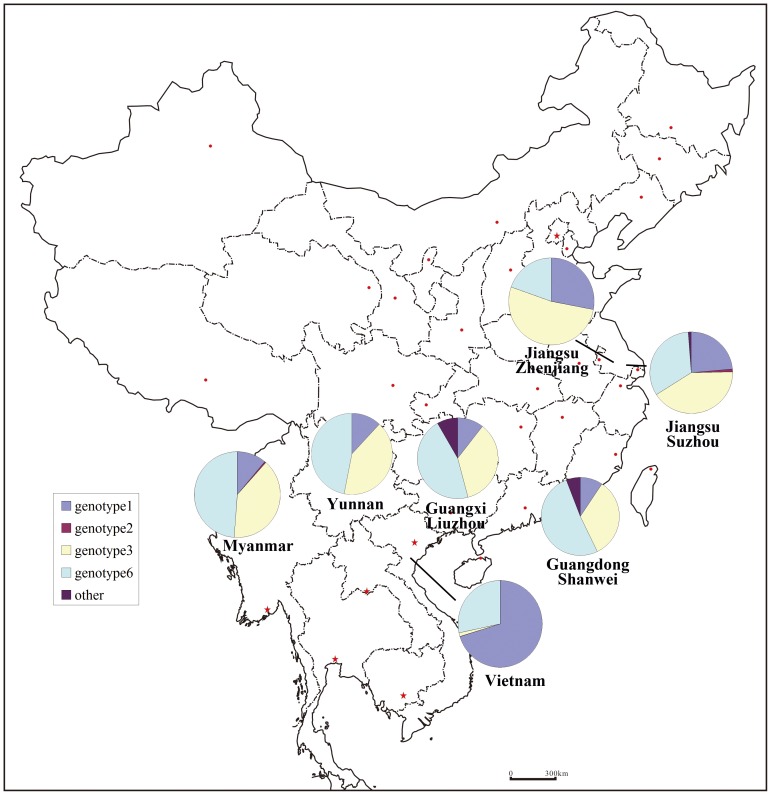
A map of Yunnan Province and other regions and HCV corresponding HCV distribution patterns.